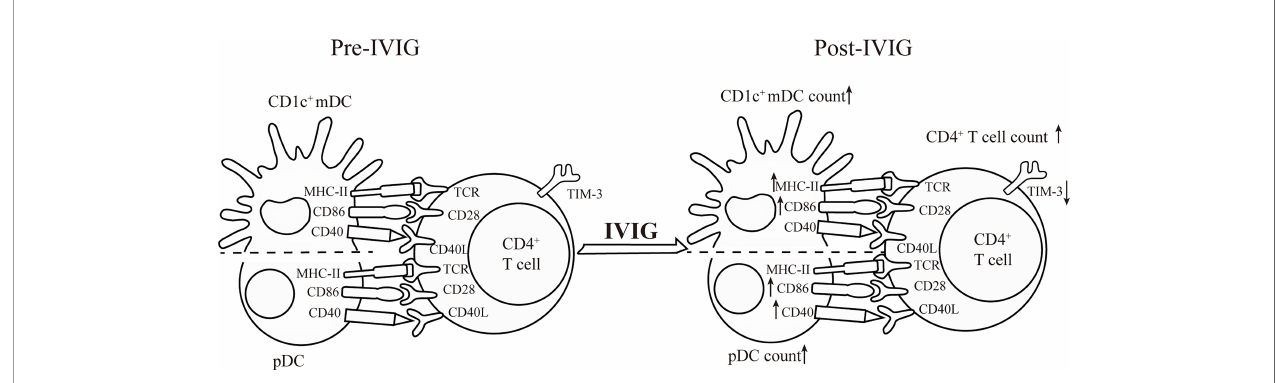
FIGURE 6 | Cartoon chart shows the effects of IVIG on the quantity and functional molecules of DC subsets and CD4 + T cells in